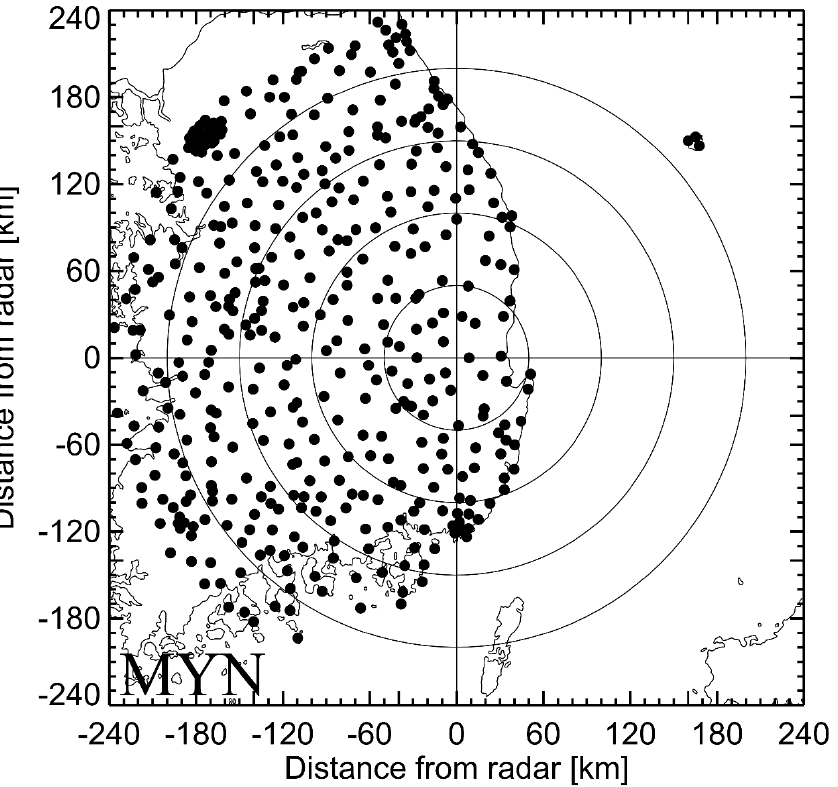
Figure 1. The locations of Automatic Weather Stations (dots) within the radar observation range of the MYN radar. Black circles denote radar range rings with a 50 km interval.